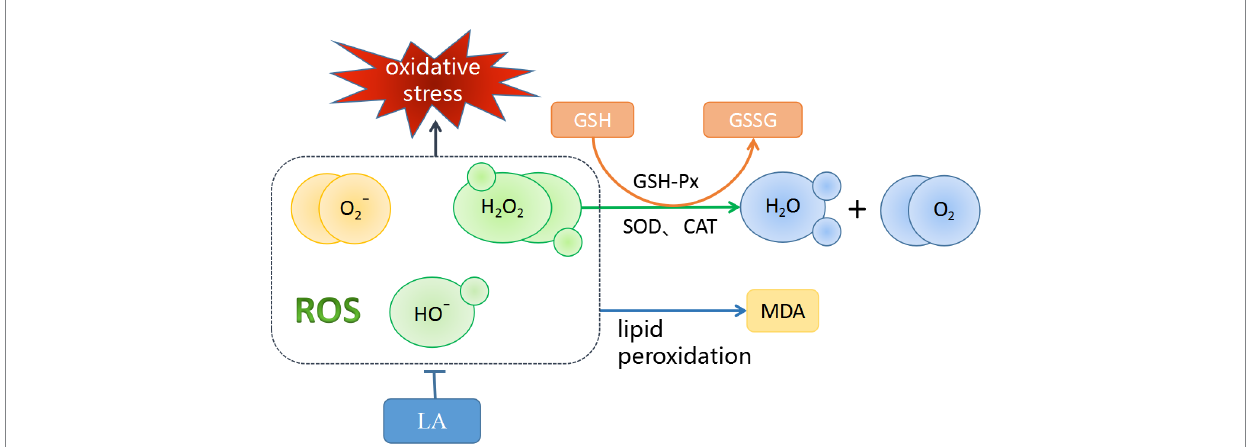
FIGURE 5 Antioxidant Mechanisms of LA. LA could scavenge ROS that play an important role in the initiation of lipid peroxidation. MDA can be used as an indirect measure of accumulated lipid peroxidation. Glutathione peroxidase (GSH-Px) is an enzyme that oxidizes reduced glutathione (GSH) to oxidized glutathione (GSSG), a process that reduces lipid peroxides to the corresponding alcohol, and reduces free hydrogen peroxide to water and molecular oxygen. Meanwhile, superoxide dismutase (SOD) and catalase (CAT) also have similar